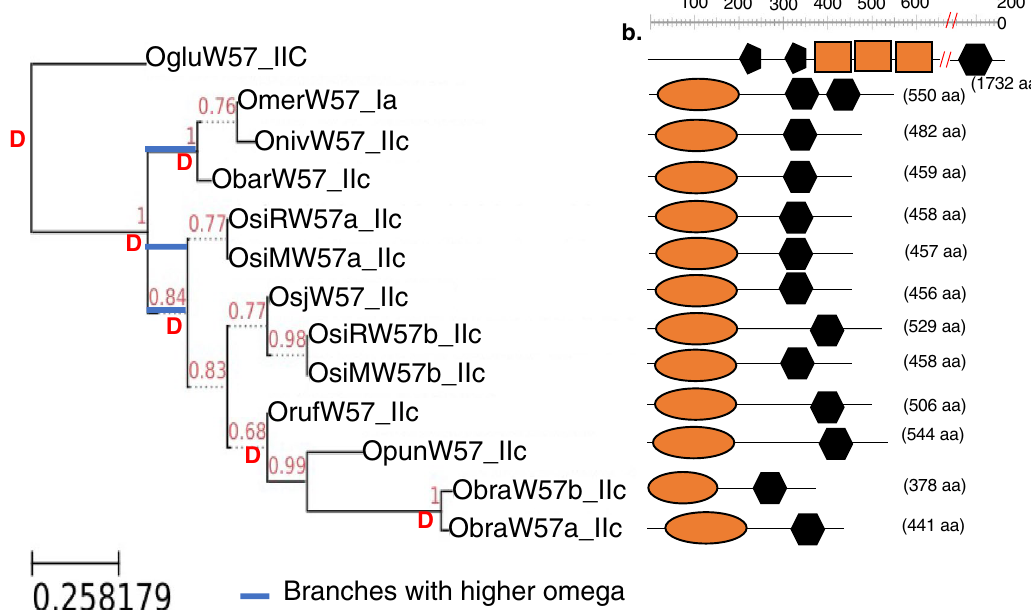
Figure 6. Estimation of gene duplication and loss events in the 11 Oryza species. ( a ) Reconciliation of rearranged maximum likelihood tree of OsW57 genes across Oryza genomes with the species tree (Fig. 3) using NOTUNG v2.9. (Duplication-Loss Model). D represents duplication events. Nodes indicate bootstrap values for 1000 replicates. Blue bar indicates branches with higher ω values. ( b ) Graphical view of ScanProsite predicted domain features are presented on the right. SPHERE: ULP protease; PENTAGON: EF-hand calcium-binding; HEXAGON: WRKY domain; RECTANGLE: solute carrier